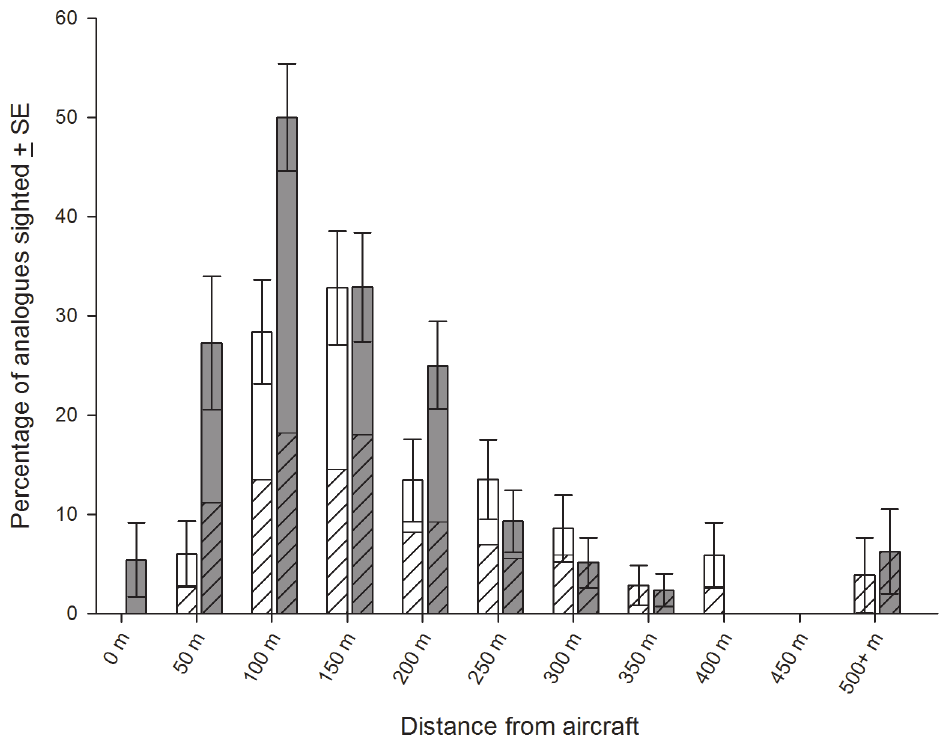
Figure 2. Percentage of validated analogue sightings per aircraft with the relative contribution of different trial treatments. Open bars indicate fixed-wing data, closed bars indicate helicopter sightings. Hashed bars indicates contribution of trials using standard methodology (cruising speed, no orbiting), non-hashed bars indicates contribution of alternative trials (orbiting permitted (fixed-wing), 100 kts airspeed (helicopter)). Contribution of each treatment type has been scaled to account for differences in sample size.